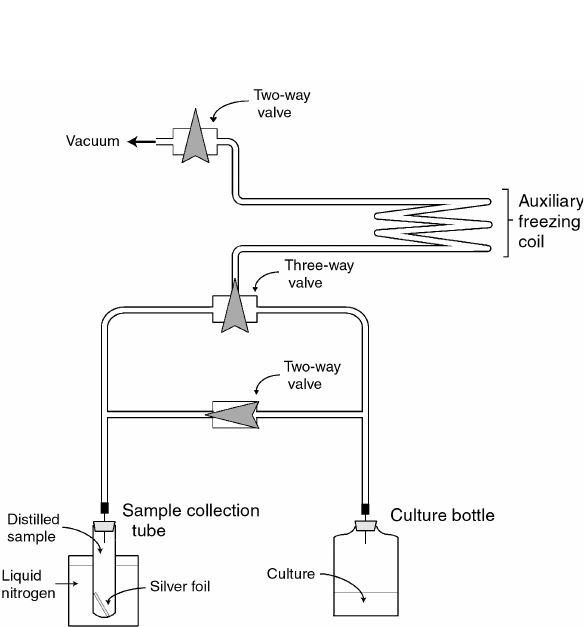
Figure 1. The distilling apparatus used to isolate CO 2 cryogenically from pressurized culture bottles after growth. Sample was introduced to the system through a needle. Liquid nitrogen collected CO 2 in a separate sample tube, allowing for subsequent removal of non-con- densable gases by a vacuum. The auxiliary freezing coil was also cooled by liquid nitrogen and served as a secondary trap for assuring no CO 2 loss. Heating the auxiliary freezing coil after removing non- condensable gases allowed any trapped CO 2 to migrate to the sample